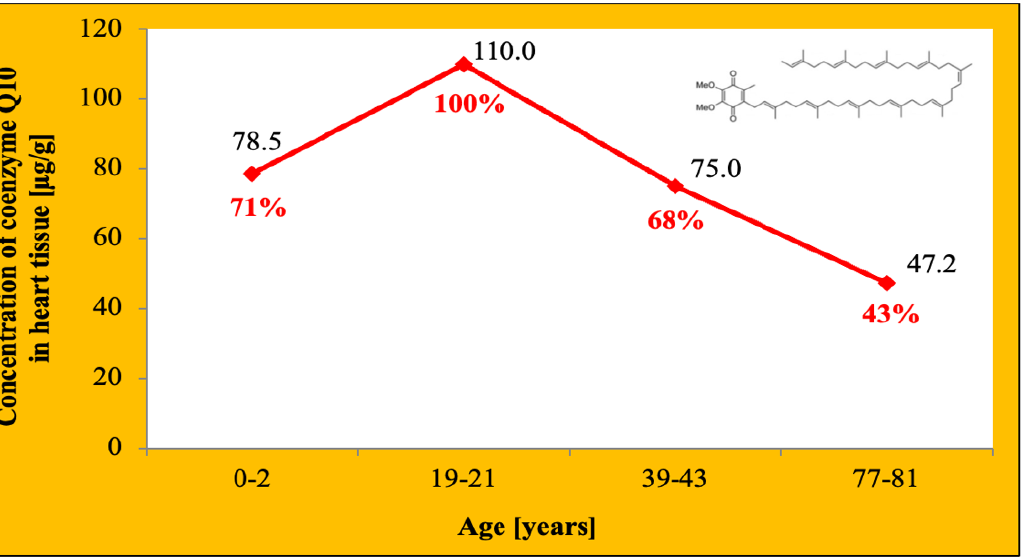
Figure 4. Changes in the concentration of coenzyme Q10 in the heart tissue depending on human age. Based on information from [24].